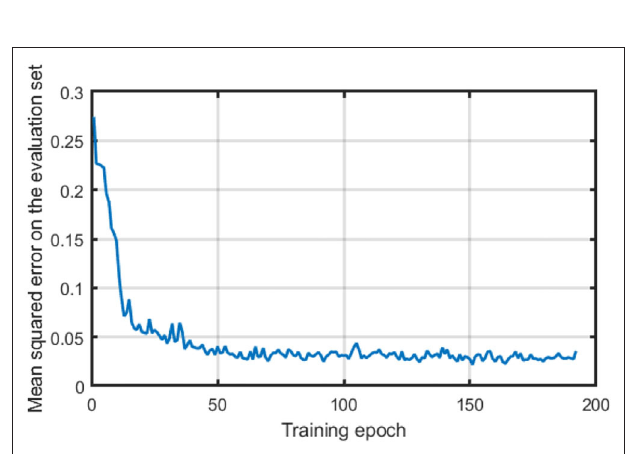
FIGURE 3 | The mean squared errors on the evaluation set during the supervised training